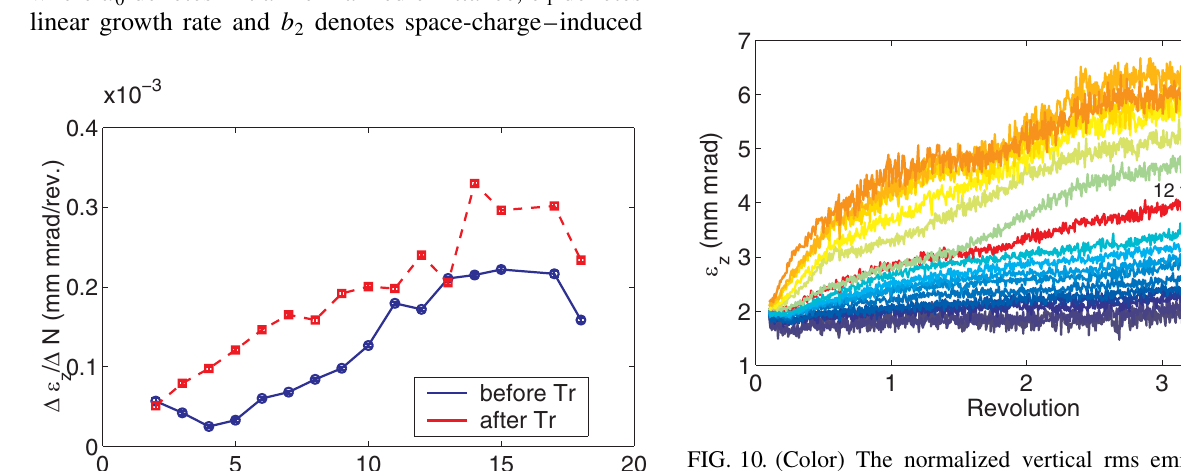
FIG. 10. (Color) The normalized vertical rms emittance from 70 revolution to 4000 revolution for all data sets with 2-turn injection to 18-turn injection. Note the red curve is for 12-turn injection which marks the border of two kinds of emittance growth behavior.